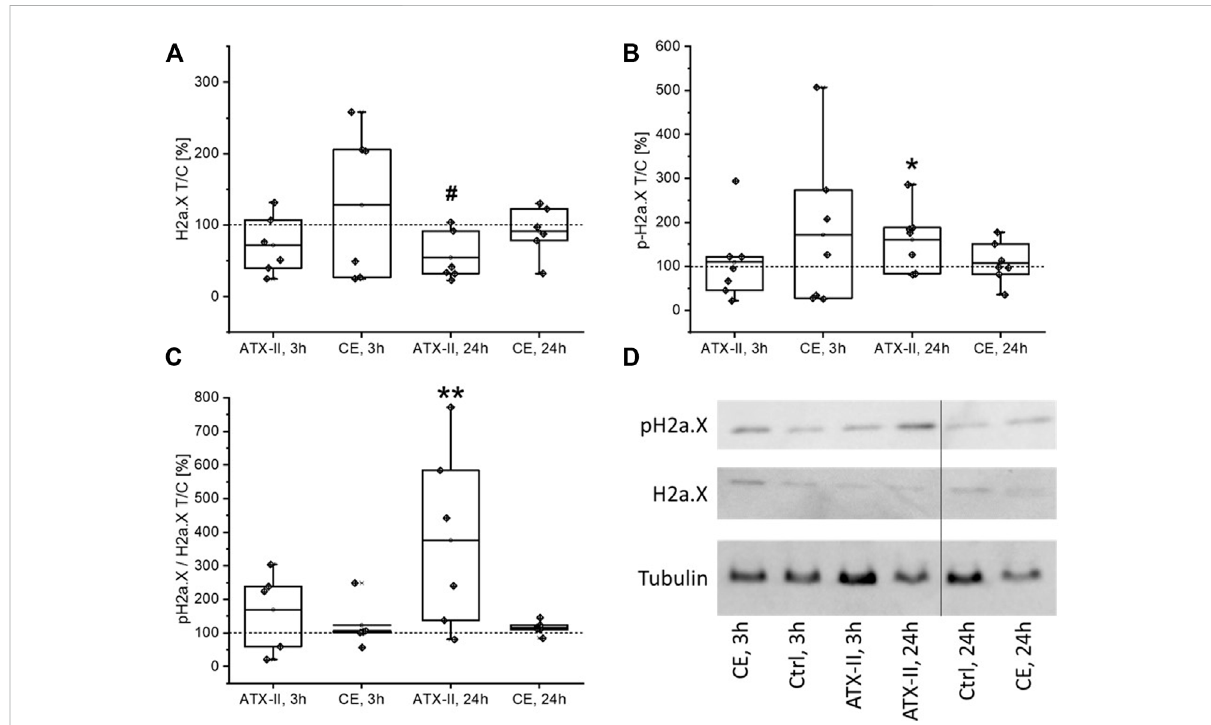
FIGURE 2 The impact of oral uptake of altertoxin-II (ATX-II) or a complex extract (CE) of Alternaria toxins on H2a.X phosphorylation and depletion in the colon of rats, at 3 h or 24 h after administration, as measured by SDS-PAGE/Western Blotting. (A,B) depict protein levels of H2a.X and its phosphorylatedform,pH2a.X,respectively,asboxblotsanddatapointsforthesinglerats.Likewise,theratioofphosphorylatedtonativeH2a.Xlevels for each rat are displayed in (C) . All data was normalized to the respective control (Ctrl) rat receiving the solvent that was analyzed in the same experiment, as indicated by dotted lines. Normal distribution of data was con fi rmed by Shapiro-Wilk testing. Signi fi cant differences to the control group were calculated using one-way ANOVA, followed by Fisher LSD post-hoc testing, and are indicated by “ * ” ( p < 0.05) or “ ** ” ( p < 0.01). In case one-way ANOVA gave inconsistent results due to the high variability within other groups, signi fi cance testing was repeated using Student ’ s t-test against the control group, with positives indicated by “ # ” ( p < 0.05). A representative image of membranes of one experiment is given in sub- Panel (D)